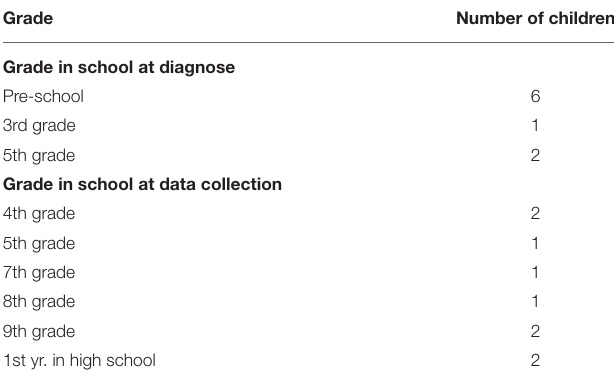
TABLE 2 | Grade in school at diagnose and data